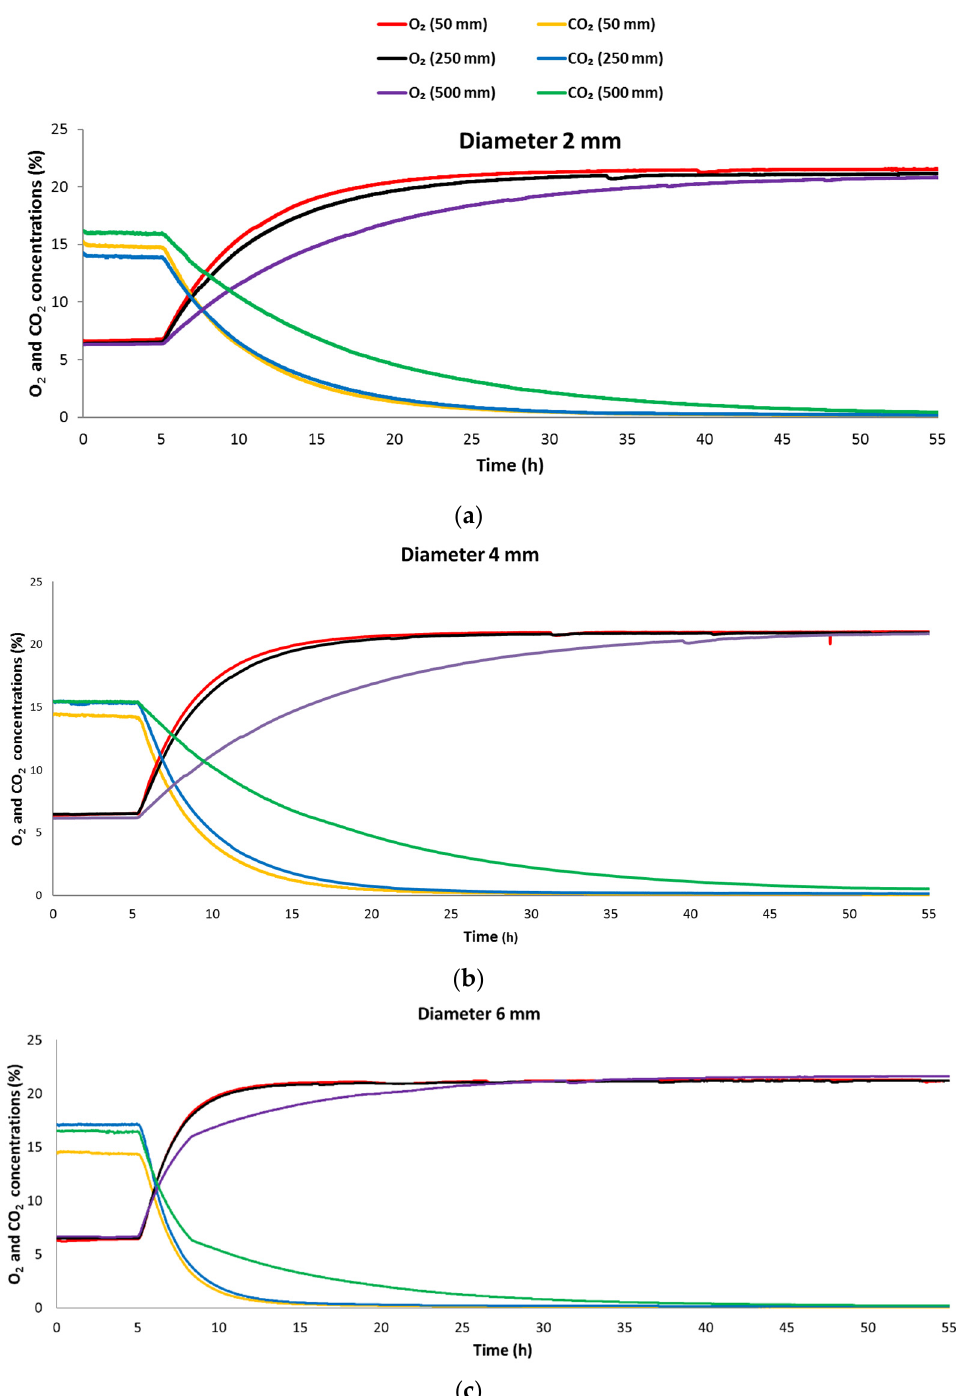
Figure 2. Data collected in real time for changes in the concentrations of O 2 and CO 2 over time in an empty metal box flushed with 15% O 2 and 5% CO 2 and fitted with one metal tube (combinations of L of 50 mm, 250 mm, and 500 mm and D of ( a ) 2 mm, ( b ) 4 mm, and ( c ) 6 mm; nine unique experiments) and a mini blower continuously ON after 4 h of flushing.